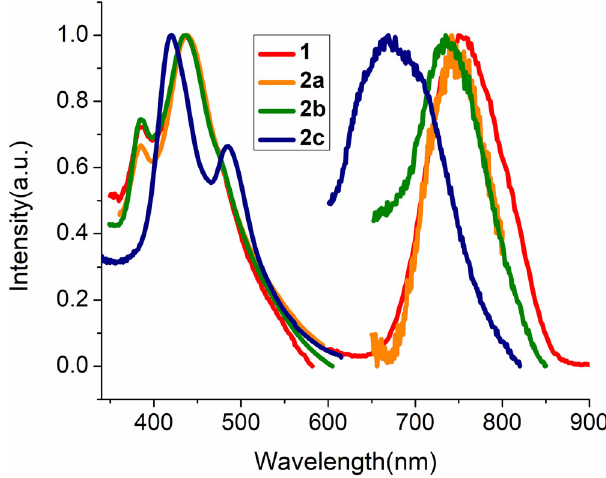
Fig. 7 Photophysical properties. UV – vis spectrum (left) of 1 , 2a , 2b and 2c in 1 ×10 − 5 M CH 2 Cl 2 and the normalized emission spectrum (right) of 1 , 2a , 2b and 2c in MeTHF at 77 K.